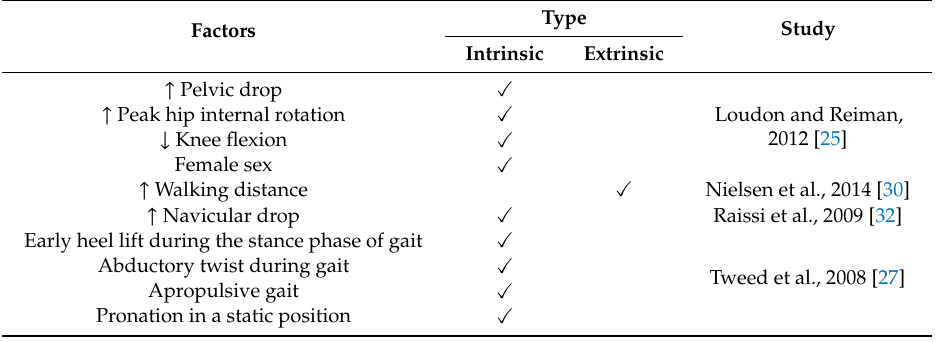
Table 4. Main statistically significant factors of Medial Tibial Stress Syndrome.